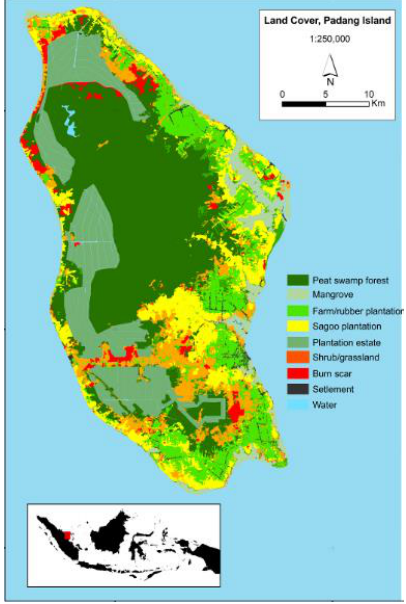
Figure 1. Study Area in Padang Island, Riau